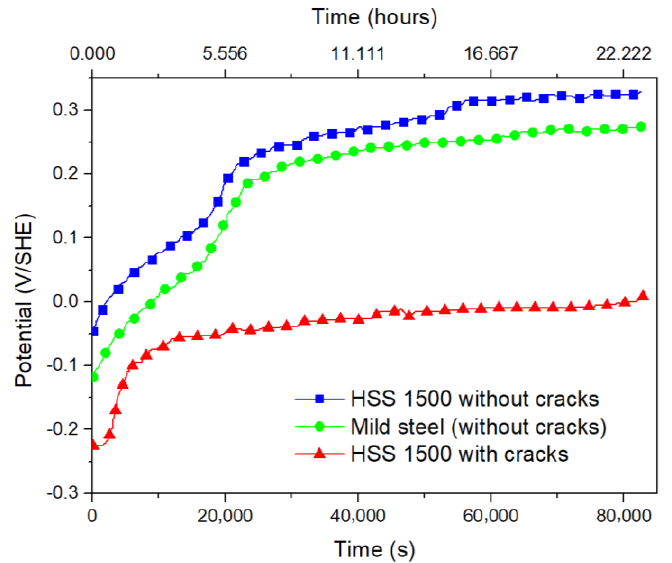
Figure 7. Monitoring of the potential of the mild steel and HSS 1500 in air after cathodic polarization at − 25 mA/cm 2 during 25 h above the surface with the cracks in HSS 1500 and without cracks (HSS1500 and mild steel).